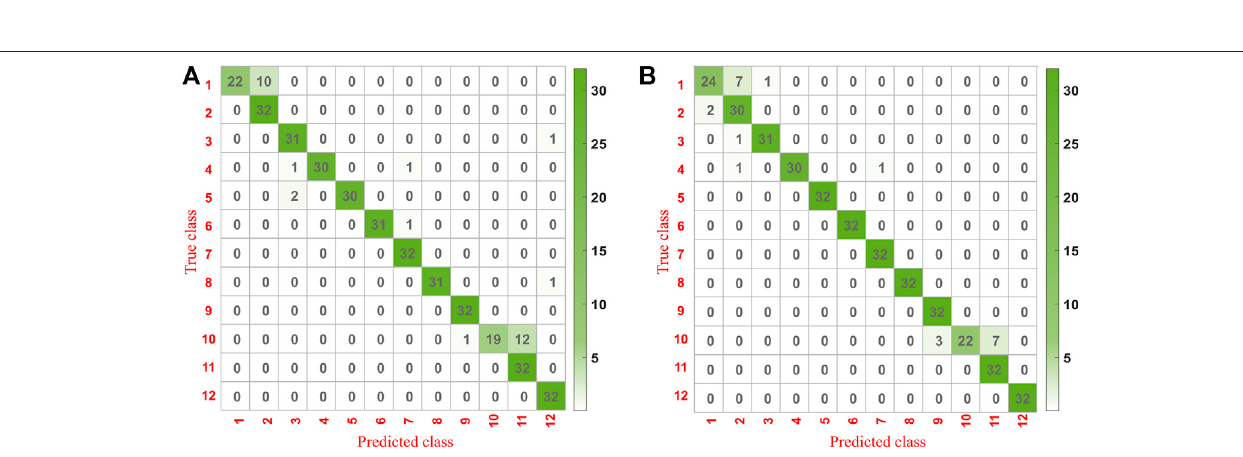
Frontiers in Arti fi cial Intelligence |